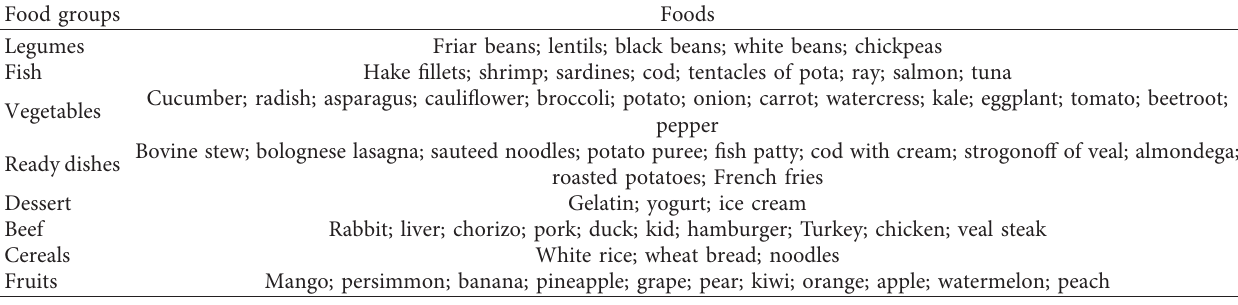
Table 6: Foods considered in the research questionnaire.